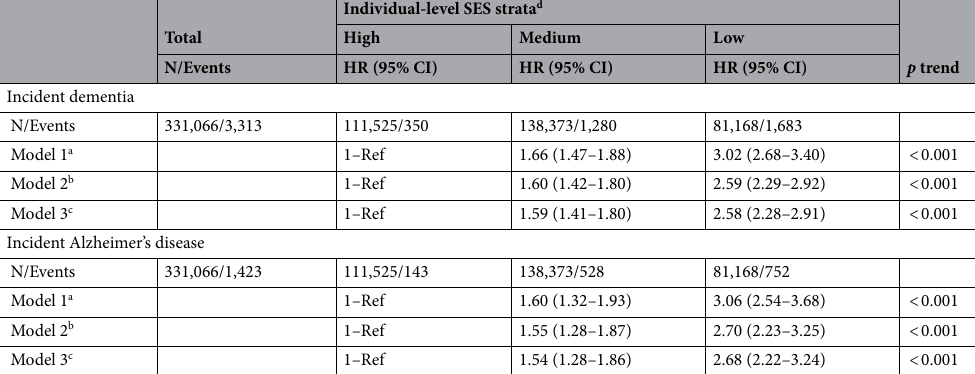
Table 2. Associations of individual-level socioeconomic status (SES) with risks of incident dementia and Alzheimer’s disease among UK Biobank participants. a Model 1 included age and sex. b Model 2 included variables in Model 1 and additionally adjusted for ethnicity, healthy lifestyle score, social activities, hearing difficulty, abdominal obesity, frailty index, urbanicity and neighbourhood deprivation. c Model 3 included variables in Model 2 and additionally adjusted for biological age (measured as residual of leucocyte telomere length, LTL, adjusted for chronological age, C-reactive protein and co-morbidities). leucocyte telomere length, LTL). d Individual-level SES is derived from latent class analysis by using participants’ reported data on highest education attainment, employment status and household income. CI Confidence interval; HR Hazard ratio; N Number of participants.